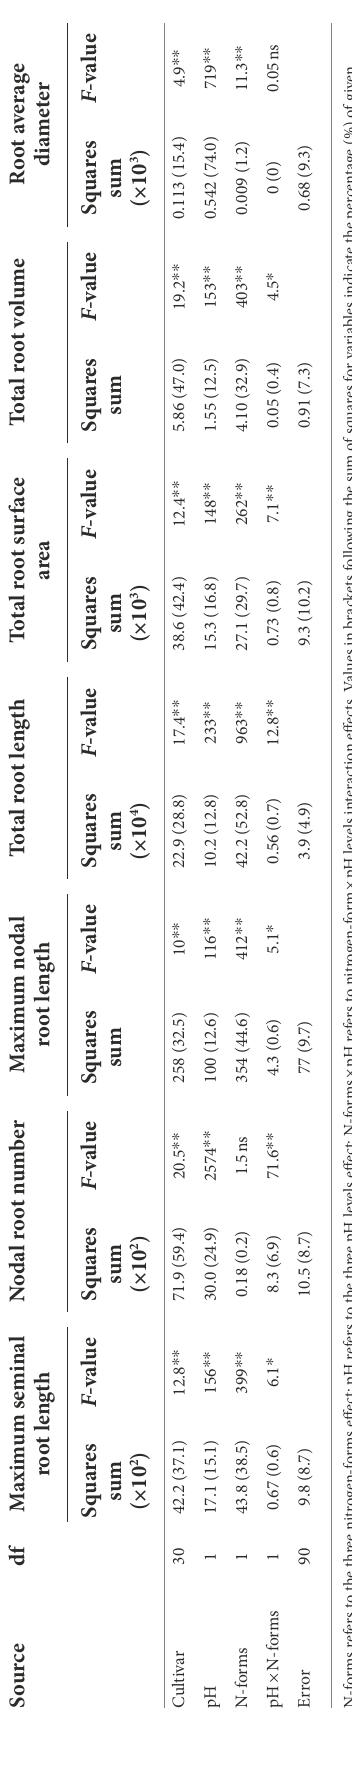
N form, and pH level, but changes in cultivars caused the highest proportion of the variance (47.1%) in shoot; but N forms explained the largest proportion of total variance (77.0%) in root.